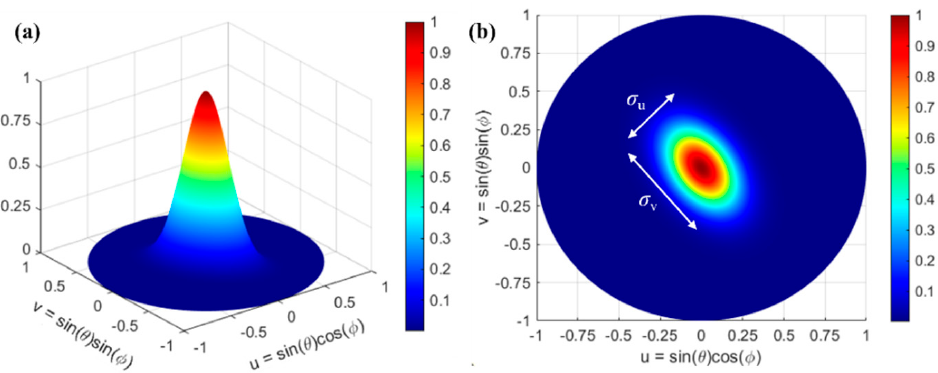
Figure 4. The generated Gaussian beam of the m th nano-antenna with σ u = 0.1 and σ v = 0.18. ( a ) 3D view and ( b ) 2D view.